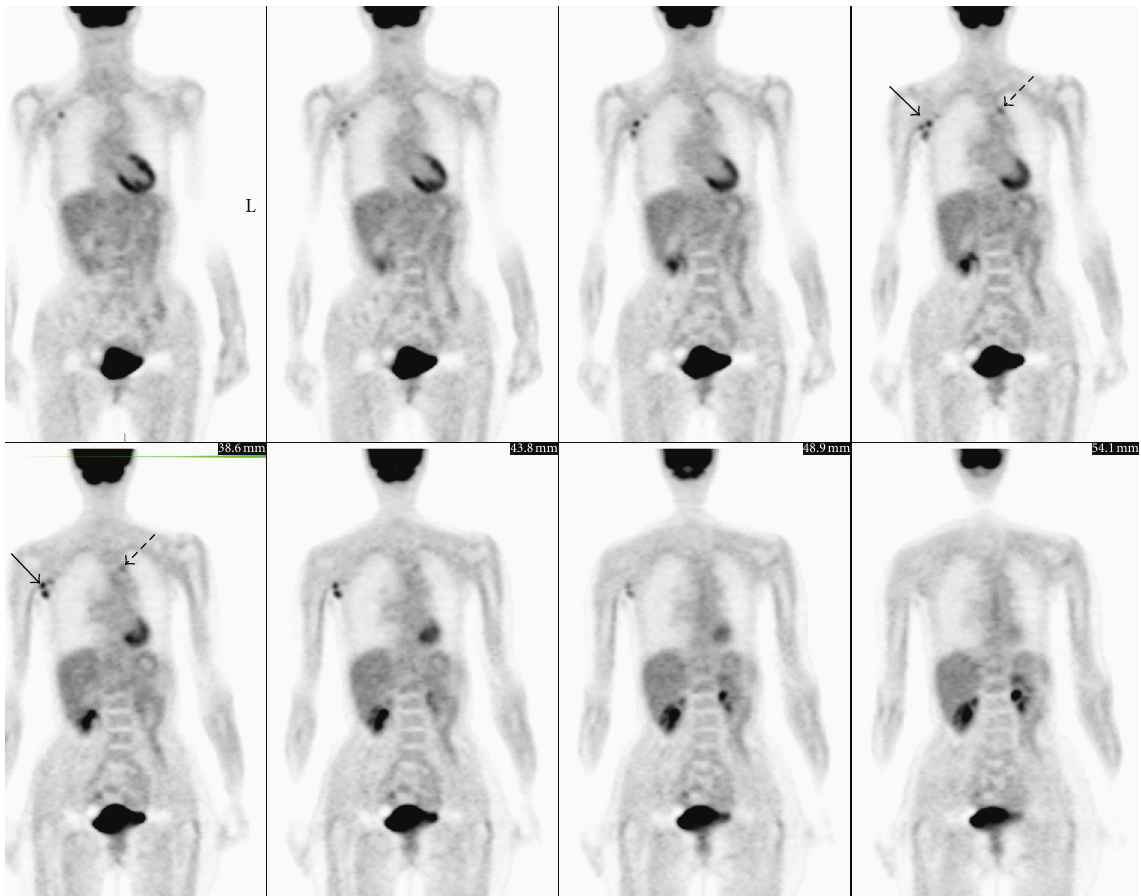
Figure 1: Coronal FDG-PET images showed a focus of mildly increased FDG activity (SUV max = 2, 1) in the medial segment of the upper lobe in the left lung (dotted arrows) and multiple moderate to markedly increased FDG foci (SUV max = 3, 4) in the right-sided axillary lymph nodes (arrows) in a 63-year-old woman, who underwent FDG-PET scan for the evaluation of enlarged right axillary lymph nodes and lung nodules, for the detection of recurrent metastatic breast cancer disease. Histopathologic examination of the axillary and endobronchial lesions revealed